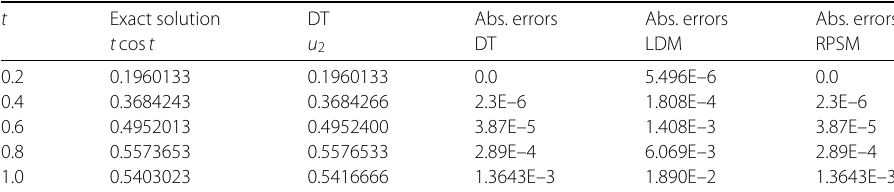
Table 2 Error analysis of u 2 on [0,1]